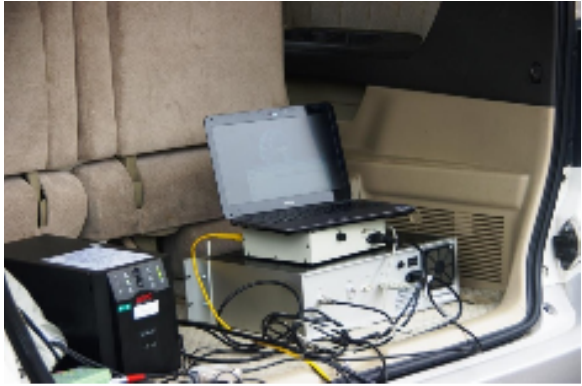
Figure 8. LEX signal receiving apparatus